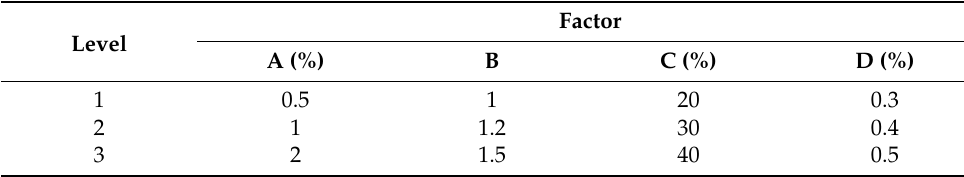
Table 4. Experiment factor level table.